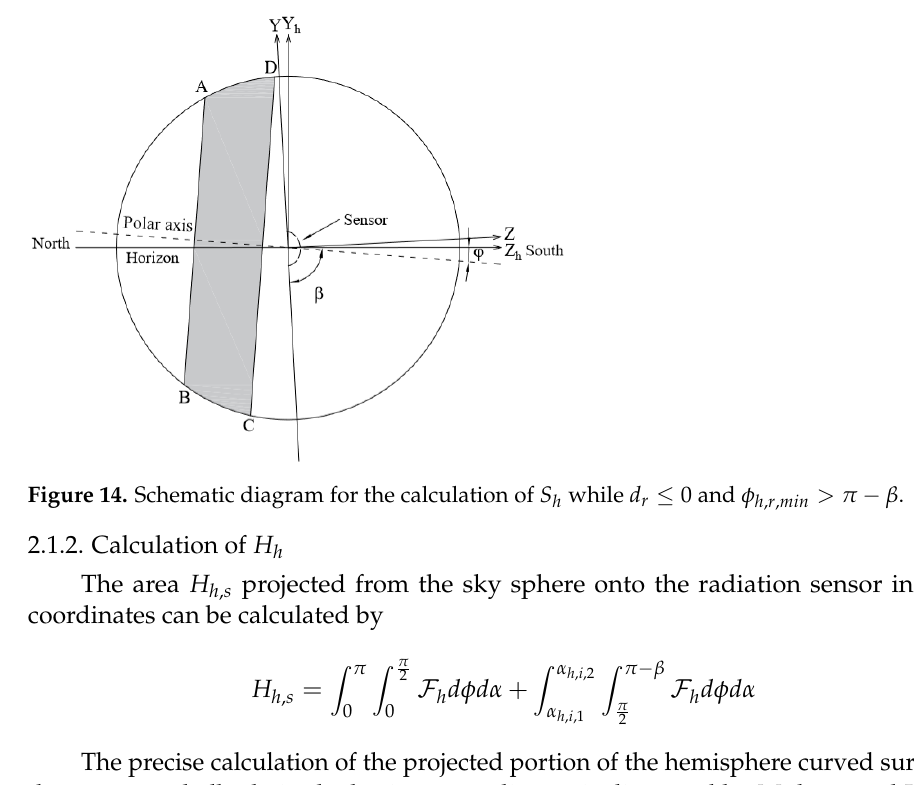
Figure 13. Schematic diagram for the calculation of 𝑆 (cid:3035) while 𝑑 (cid:3045) ≤ 0 and 𝜙 (cid:3035),(cid:3039),(cid:3040)(cid:3036)(cid:3041) > 𝜋 − 𝛽 >